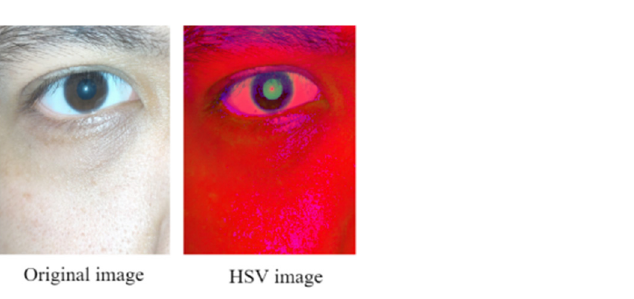
Figure 33. Original RGB image and corresponding image obtained after HSV color conversion.